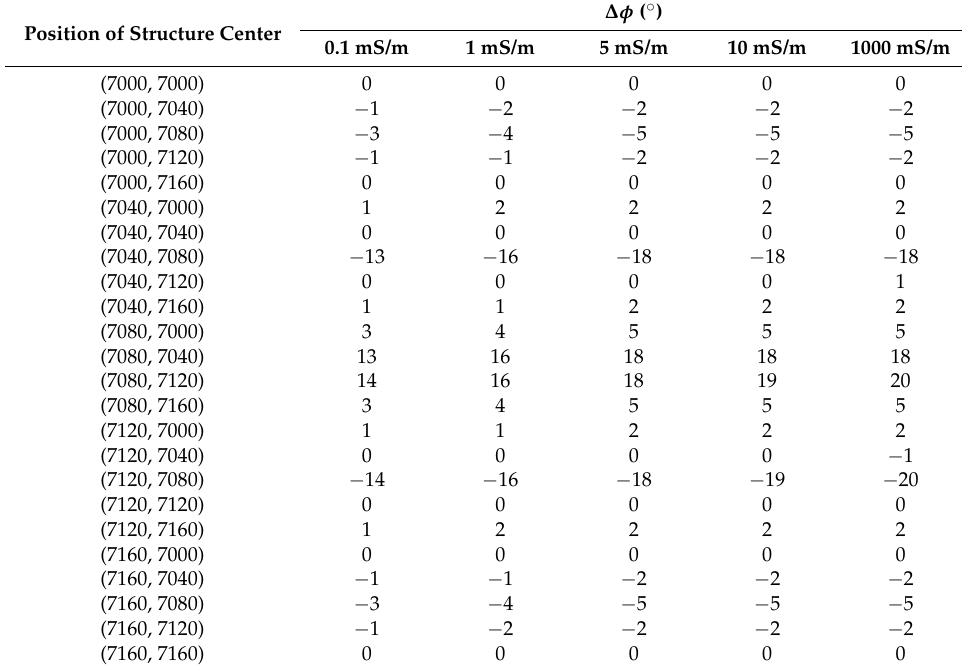
Table 4. FDTD-computed azimuth errors (in degrees) estimated from Equation (2) for true azimuth